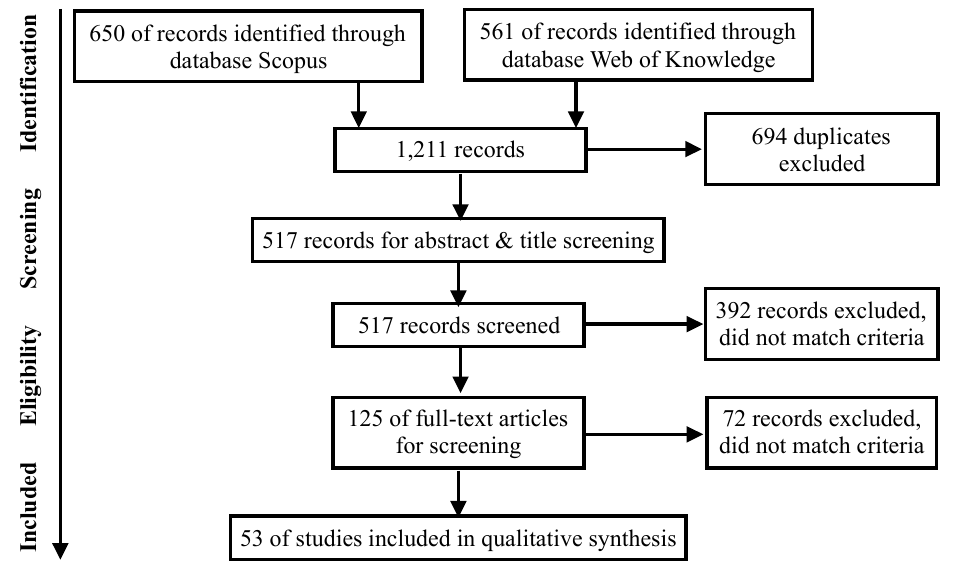
Figure 2. Process of the systematic review.